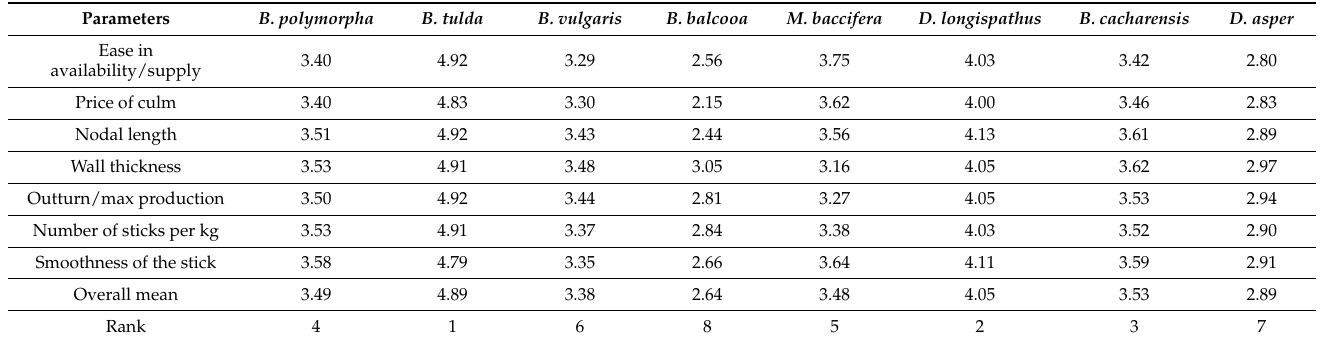
Table 1. Scores and ranking of preferential attributes from questionnaire survey for choice of bamboo species used in incense stick industry.